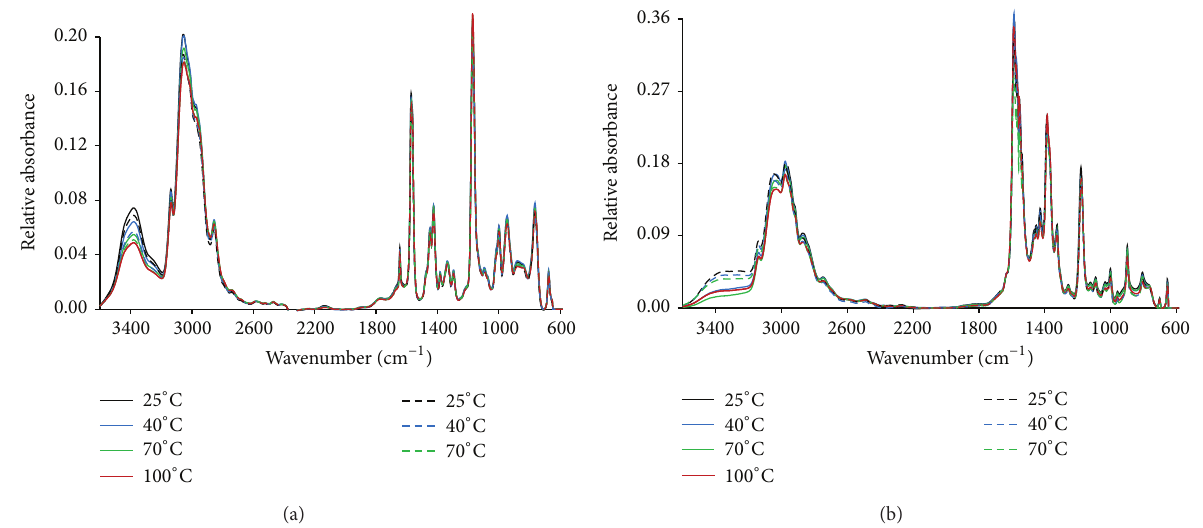
Figure 4: FTIR spectra of 2% cellulose solutions in AMIMCl (a) and EMIMOAc (b) solutions. Spectra obtained on heating (—) from 25 ∘ C to 100 ∘ C and then on cooling (- - -) to 25 ∘ C. 25 ∘ C (black), 40 ∘ C (blue), 70 ∘ C (green), and 100 ∘ C